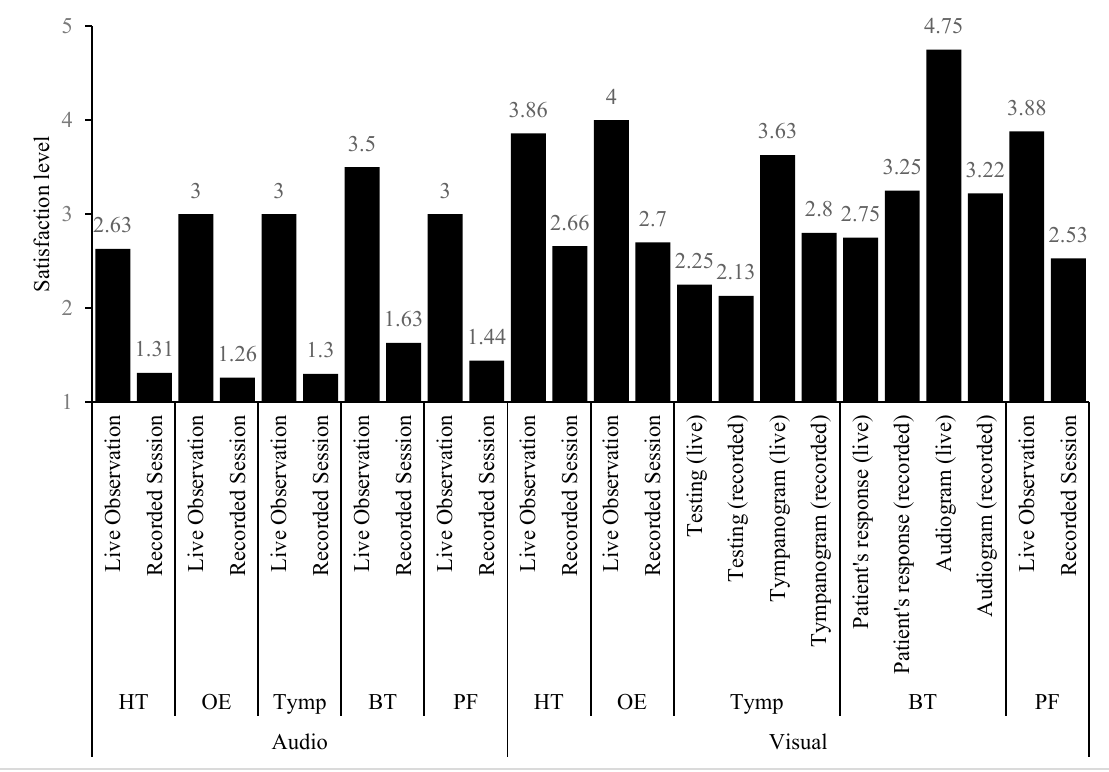
Figure A3. The satisfaction level of audio-visual quality for history taking (HT), otoscopic examination (OE), tympanometry (Tymp), behavioral testing (BT), and providing feedback (PF).